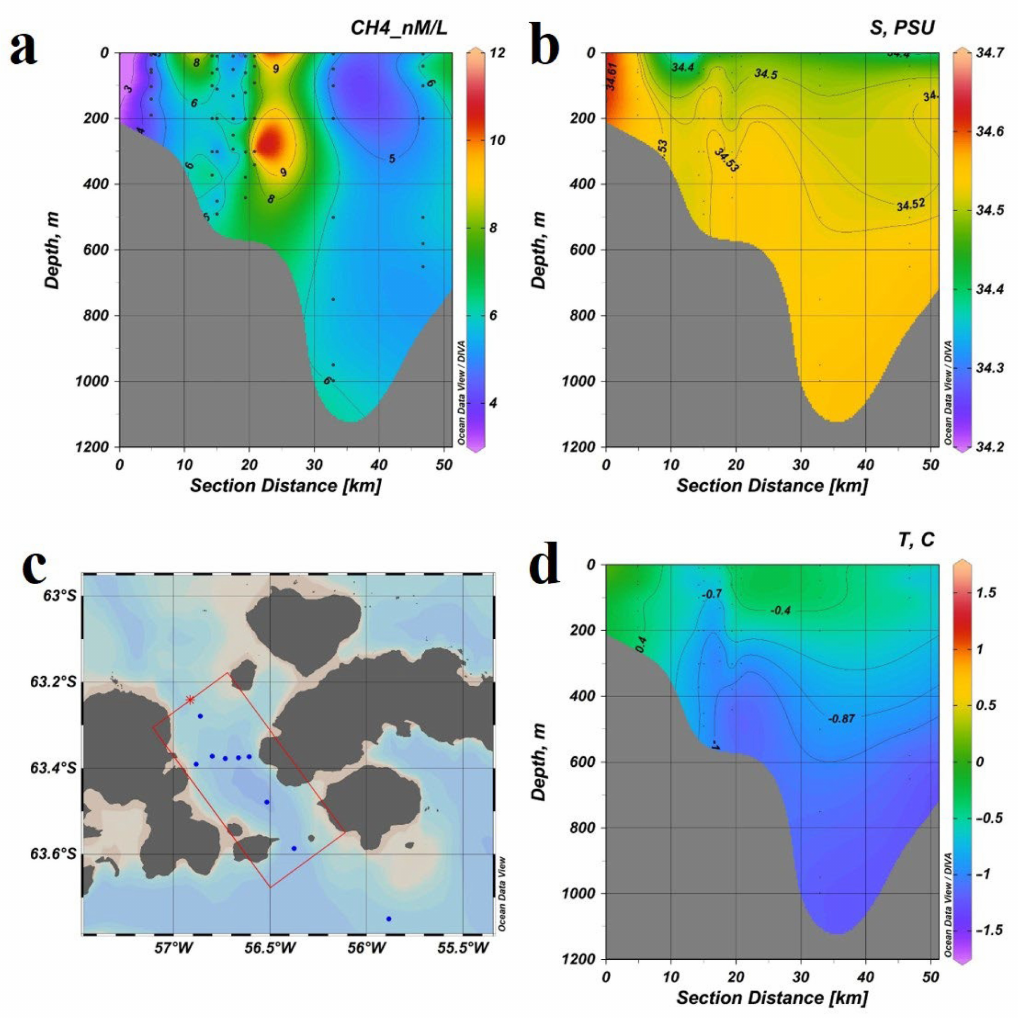
Figure 8. Distribution of methane concentration ( a ), temperature ( d ) and salinity ( b ) on the longitudi- nal section ( c ) in the Antarctic